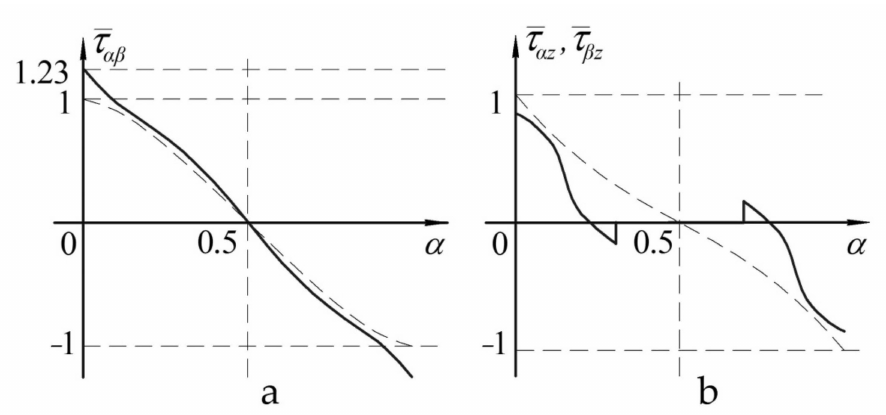
Figure 7. Distribution of tangential stresses on the upper surface of the panel ( a ) and transverse shear stresses in the layer with a notch ( b